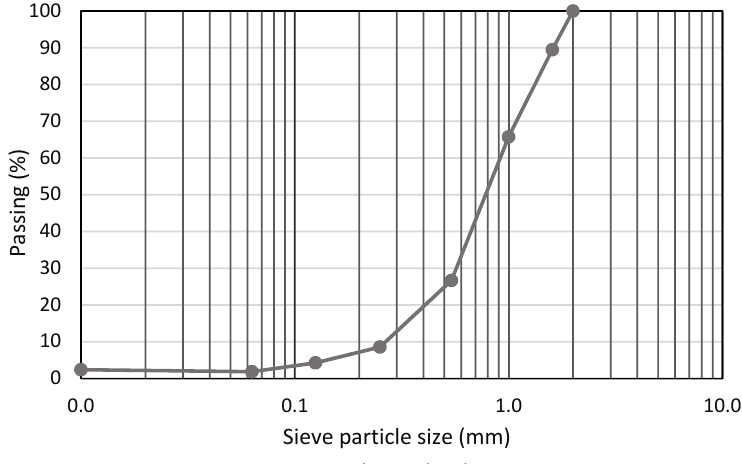
Figure 2. Particle size distribution of CDW-A.